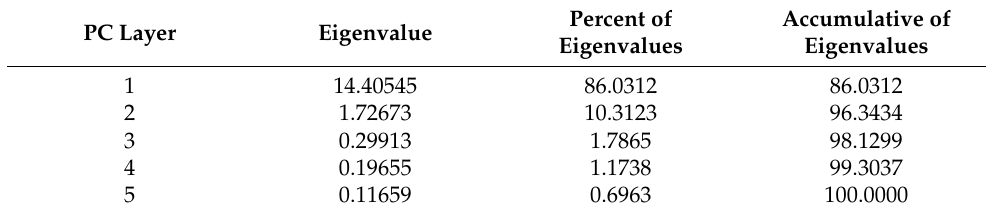
Table 3. Percent and accumulative